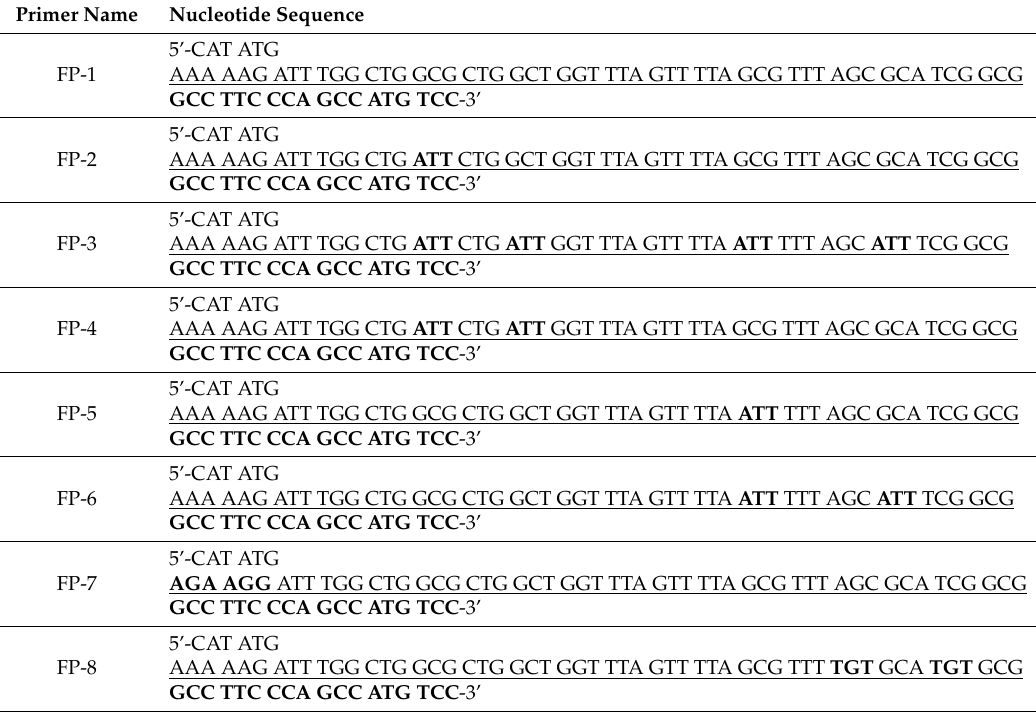
Table 1. Sequence of primers used for the construction of pOGH plasmids -1 to -8. The underlined sequence represents DsbAss, whereas bold represents the OGH cDNA sequence and the non-underlined sequence is the site for Nde I restriction enzyme. Nucleotide variation incorporated in native DsbAss are underlined and